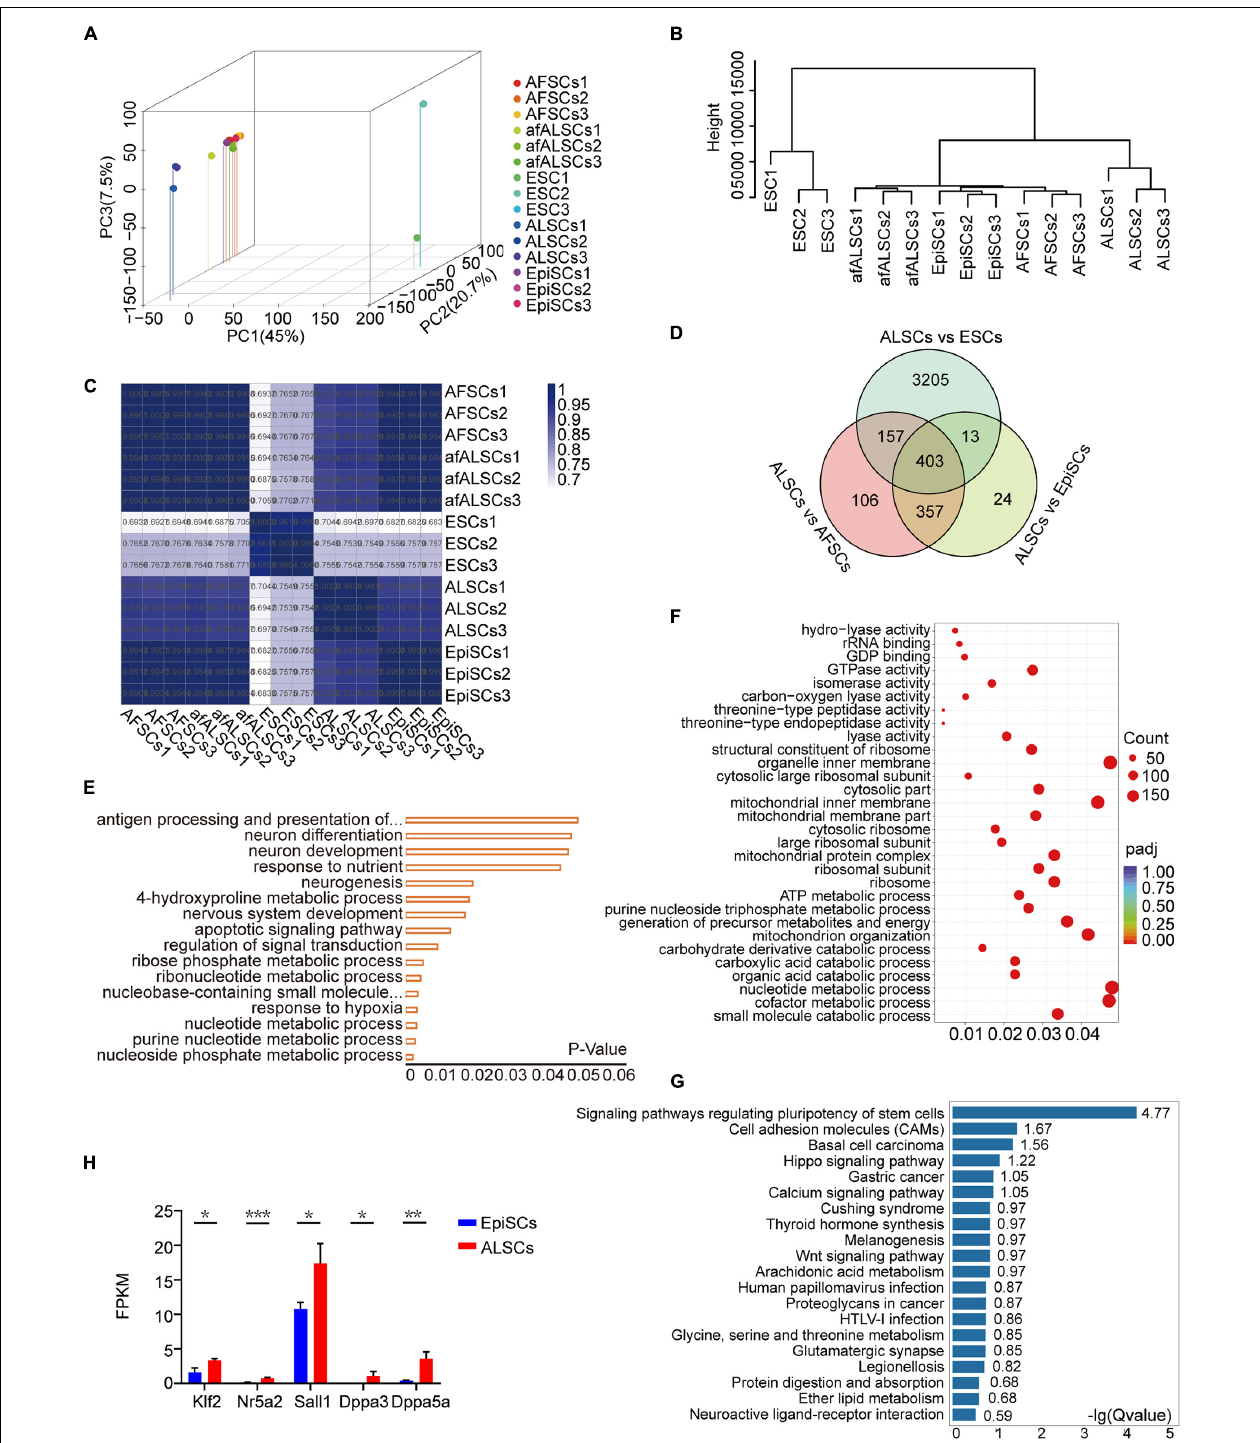
FIGURE 3 | Transcriptomic characteristics of ALSCs. (A) Three-dimensional scatter plot based on the principal component analysis of RNA-seq data from three biological replicates. (B) Hierarchical clustering of RNA-seq data of ESCs, EpiSCs, ALSCs, afALSCs, and AFSCs. (C) The correlation matrix of gene expression was clustered using Pearson correlation. (D) Venn diagram showing overlaps of the differential expression gene of ALSCs vs . ESCs, ALSCs vs . EpiSCs, and ALSCs vs . AFSCs. (E) Gene Ontology categories significantly enriched in the biological process for 403 genes from the overlap in (D) . (F) Kyoto Encyclopedia of Genes and Genomes (KEGG) pathway analysis of upregulated genes in 403 genes from the overlap in (D) . (G) KEGG pathway analysis of upregulated genes in ALSCs vs . EpiSCs. (H) Pluripotent genes and naive genes were upregulated in ALSCs.